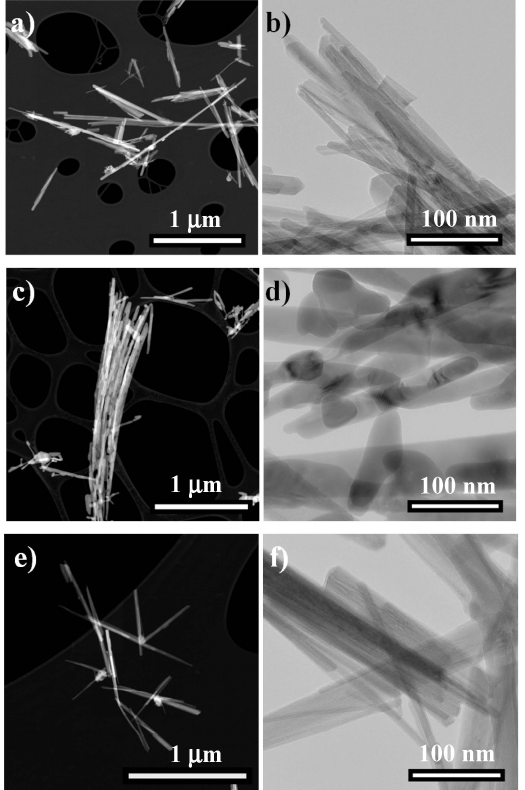
Figure 1. High-angle annular dark field (HAADF)-scanning transmission electron microscopy (STEM) (on the left) and transmission electron microscope (TEM) (on the right) images of ( a , b ) hydrothermal MnO 2 (M_hydro), ( c , d ) M_500 (500 ˝ C) and ( e , f ) M_hydro_1.0%Ag